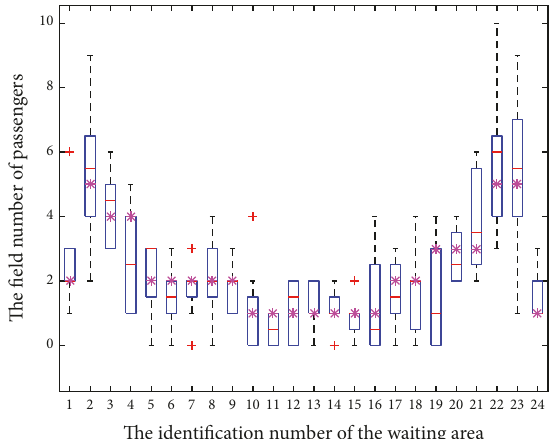
Figure 13: Box-plot for the field number of passengers at each waiting area and the simulation results of a random